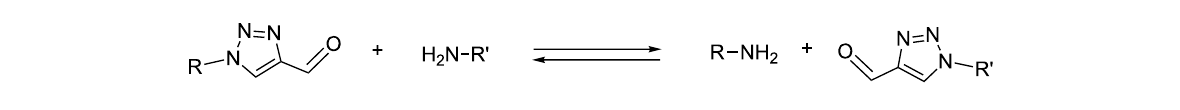
tuted-4-imino-1,2,3-triazole analogs are typically prepared from efficient condensation reactions of 1-substituted-4-formyl-1,2,3- triazoles deriving from CuAAC preparations [33,35-39]. Due to the thermodynamic stability of the imine bond at the 4-triazolyl position, this motif stands as an attractive target for designing new multidentate chelators to prepare coordination